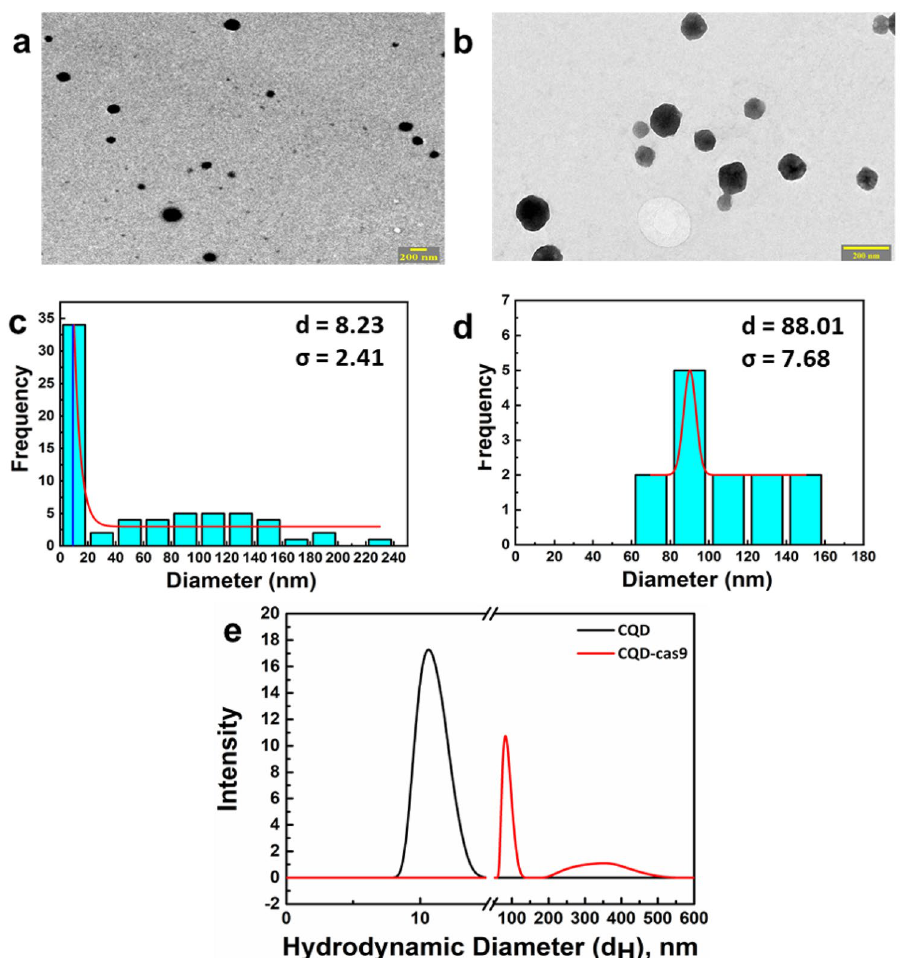
Figure 2. TEM micrographs and DLS for size determination. TEM micrographs of ( A ) CQDs and ( B ) CQD- cas9. ( C ) and ( D ) represents frequency size distribution bar graph for corresponding TEM images. ( E ) Size distribution of CQD and CQD-cas9 particle using Dynamic Light Scattering (DLS), d = mean diameter and σ = standard